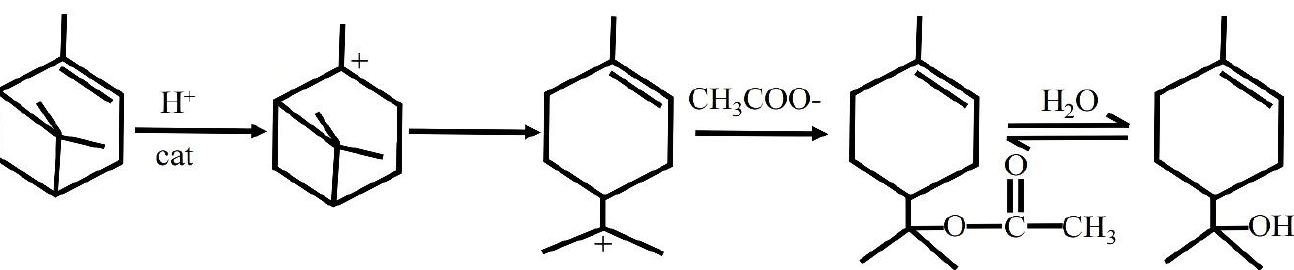
Figure 11. The main stages of the target reaction.